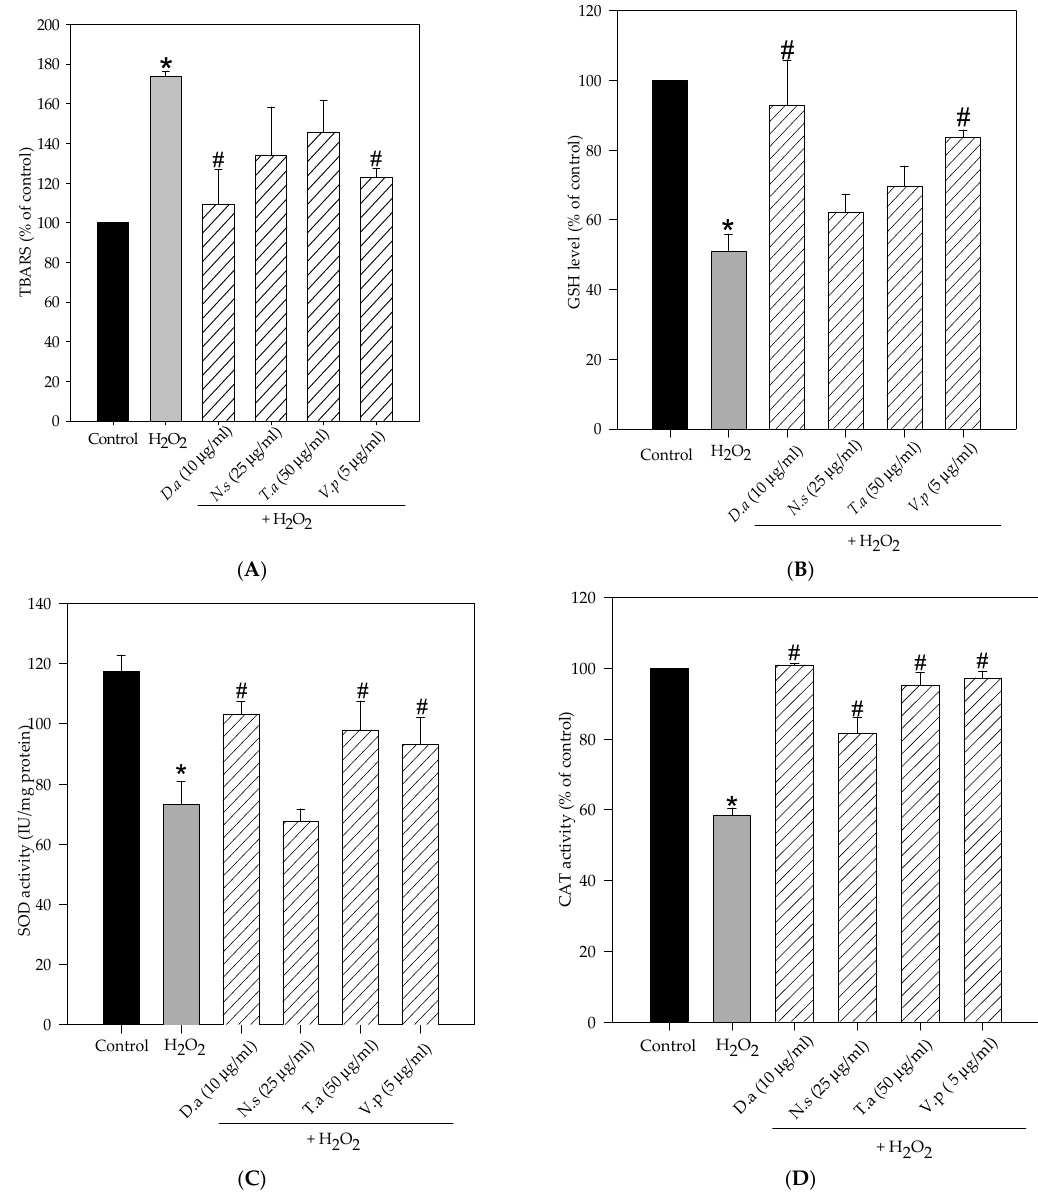
Figure 4. Lichen extracts from cetrarioid clade improved oxidative stress markers and antioxidant enzyme activity. SH-SY5Y cells were pretreated with Dactylina arctica ( D.a ), Nephromopsis stracheyi ( N.s ), Tuckermannopsis americana ( T.a ) and Vulpicida pinastri ( V.p ) for 24 h before H 2 O 2 (250 µM, 1 h). ( A ) Lipid peroxidation, ( B ) GSH levels and ( C ) SOD activity, ( D ) CAT activity. Results are expressed as mean ± SD (triplicate experiments). * p < 0.05 versus control; # p < 0.05 versus H 2 O 2.